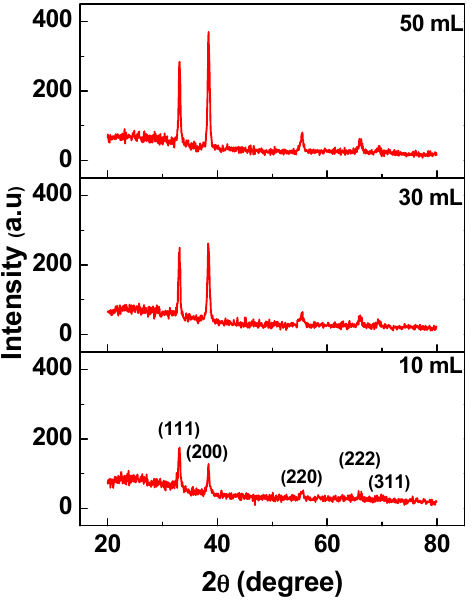
Figure 2. XRD of Sn:CdO (0.05:1 × 10 − 3 M) films with different volumes.